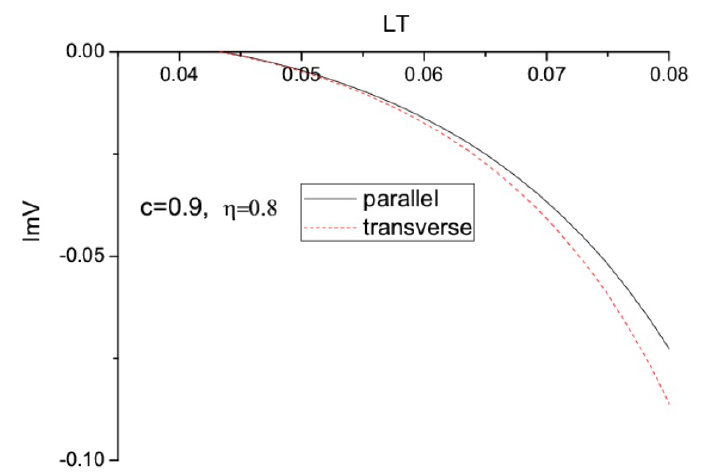
Figure 5 . Im V as a function of LT for a Q ¯ Q pair oriented parallel to the axis of the quarks, from Q ¯ Q left to right for η = 0 . 8 , 0 . 4 , 0 respectively, T = 200 MeV , in the presence of GC, for a) c = 0 . 02 Ge V 4 and b) c = 0 . 9 Ge V 4 .